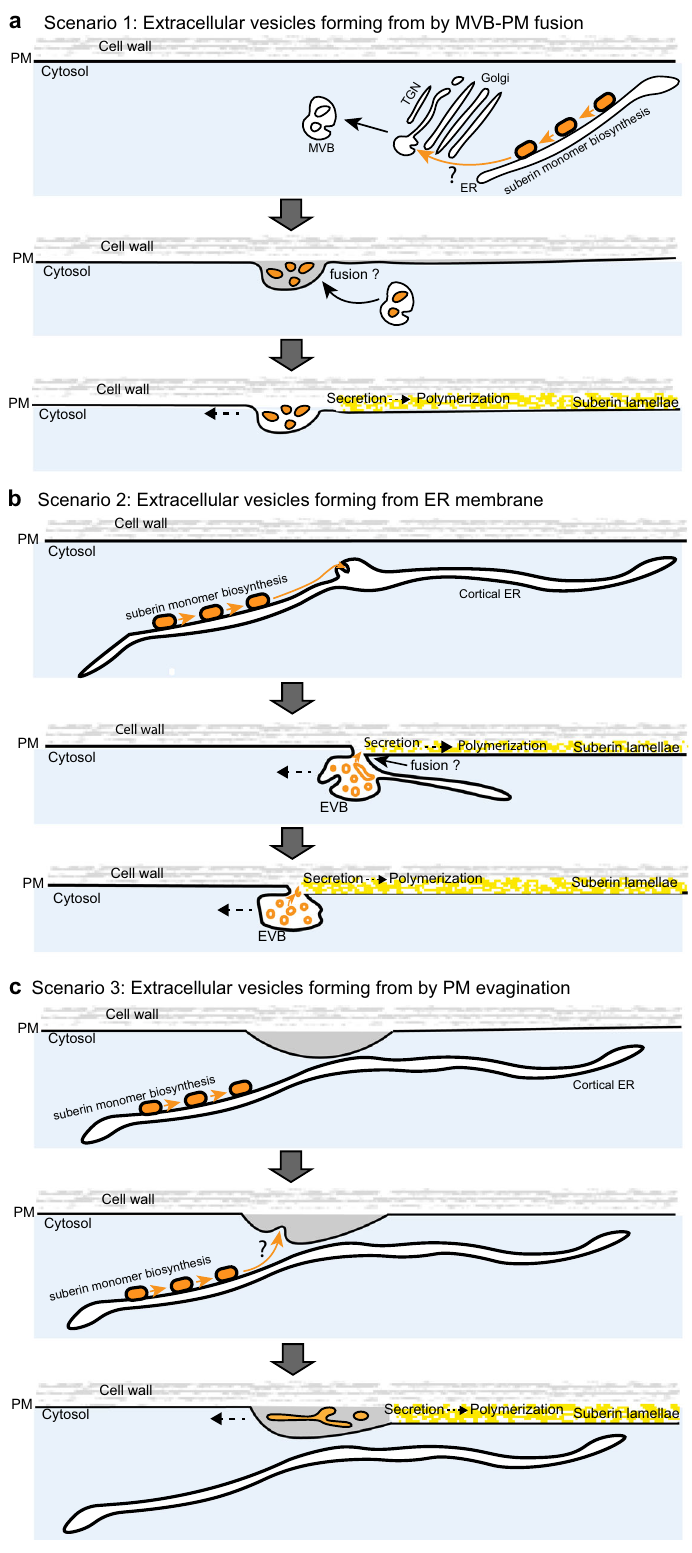
lipidic molecules to the fungus at the arbuscule and the process of transporting very similar, lipid-like suberin monomers to the apoplast during suberization. Our work here establishes a developmental role for EVBs in the formation of suberin, a major cell wall polymer, distinct from the more widely reported functions of EVBs in symbiotic and pathogenic